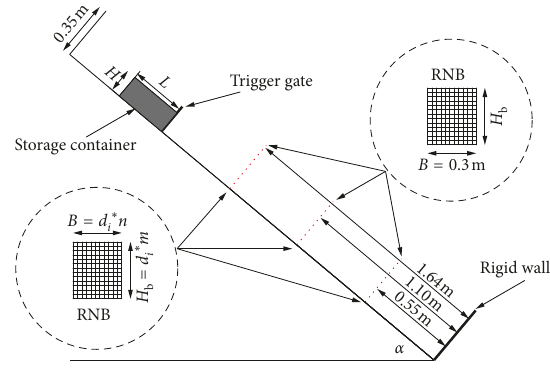
Figure 7: Setting of RNB in the flow flume.